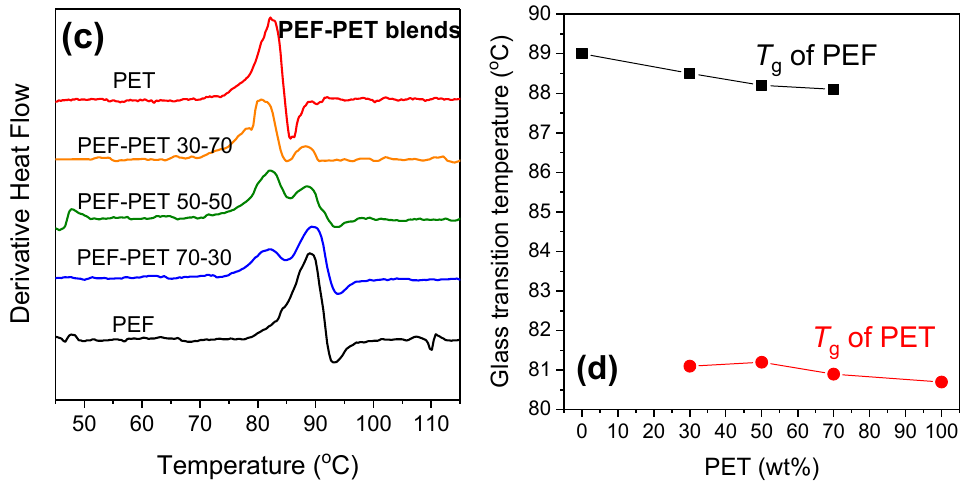
Figure 3. ( a ) DSC thermograms of PEF, PET, and their blends, ( b ) zoomed-in area of the glass temperature, ( c ) derivative of heat flow of the samples under study, and ( d ) the variation of T g with PET content.